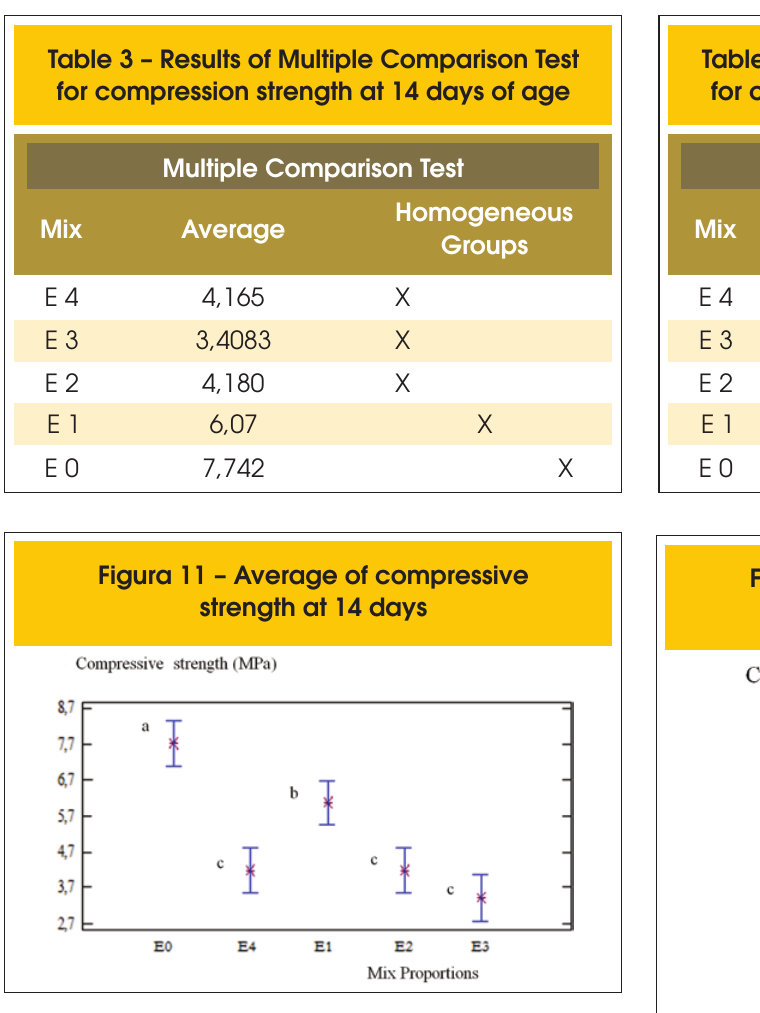
Table 3 – Results of Multiple Comparison Test for compression strength at 14 days of age